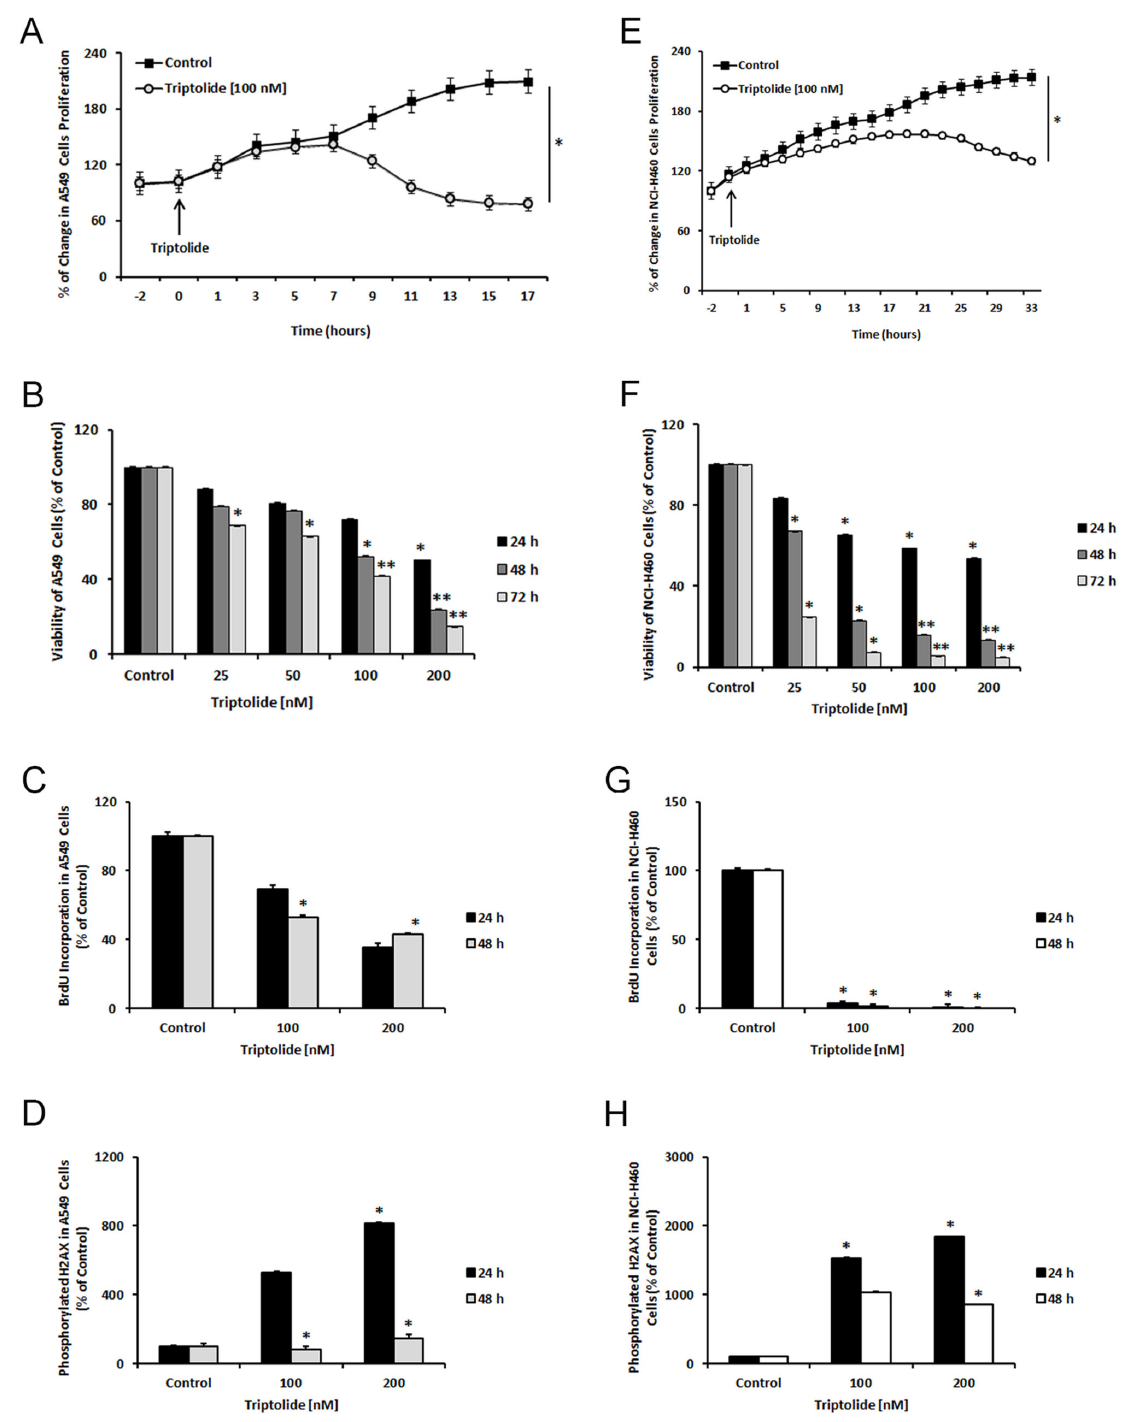
Figure 1. Triptolide decreases proliferation and viability of NSCLC cells. A549 cells (right panel) and NCI-H460 cells (left panel) were treated with 25-200 nM of triptolide for times indicated. Proliferation (A, E) and viability (B, F), as well as BrdU incorporation (C, G) were significantly reduced of both cell lines were reduced; however, the cytotoxic effect of triptolide was more pronounced in NCI-H460 cells. The indicator of DNA repair, phosphorylated H2AX, was significantly increased in both cell lines with triptolide treatment as shown (D, H). Columns , mean, bars , SE. Statistical significance of results was calculated with the Student`s t test (N=3) * P = 0.05; ** P = 0.005. doi: 10.1371/journal.pone.0077411.g001 PLOS ONE |